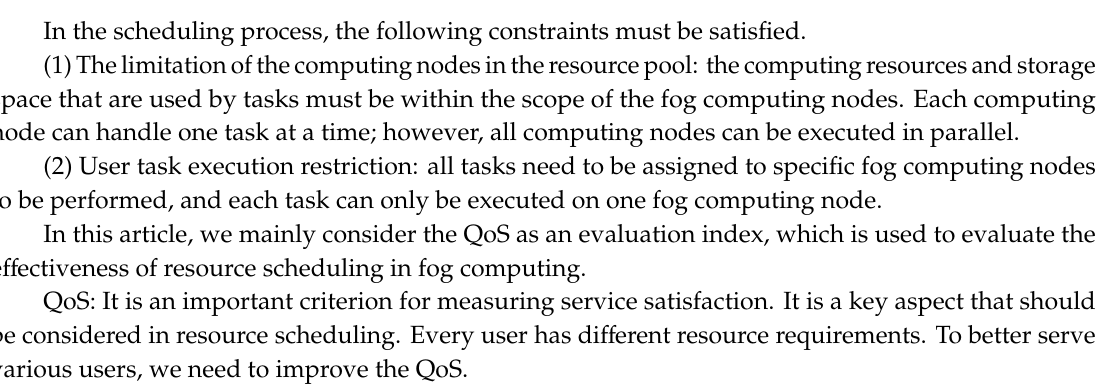
Figure 3. Fog computing resource scheduling network architecture.